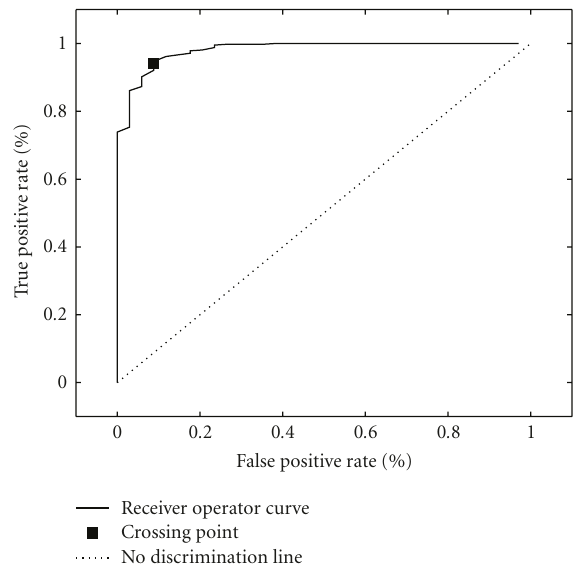
Figure 11: ROC for the “One Correlation Case.” upper limits of the correlation. These numbers are computed for each threshold value as follows.